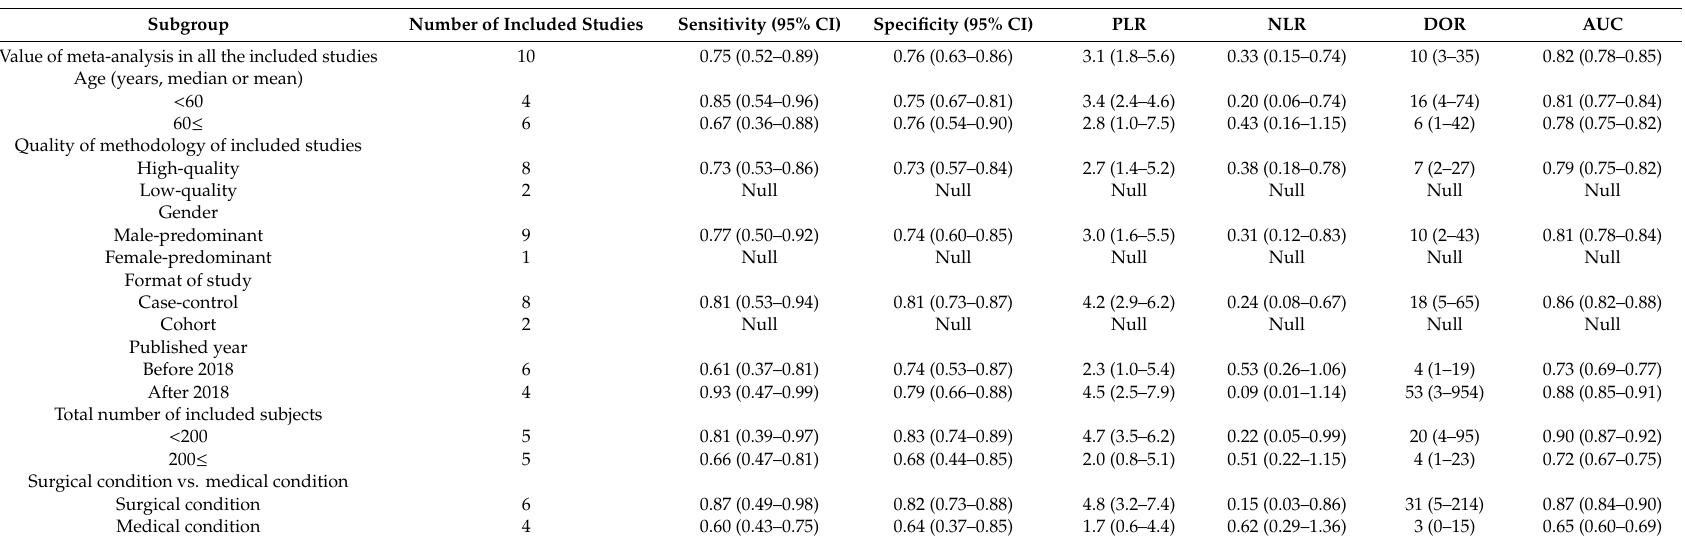
Table 2. Summary of outcome of diagnostic accuracy and subgroup